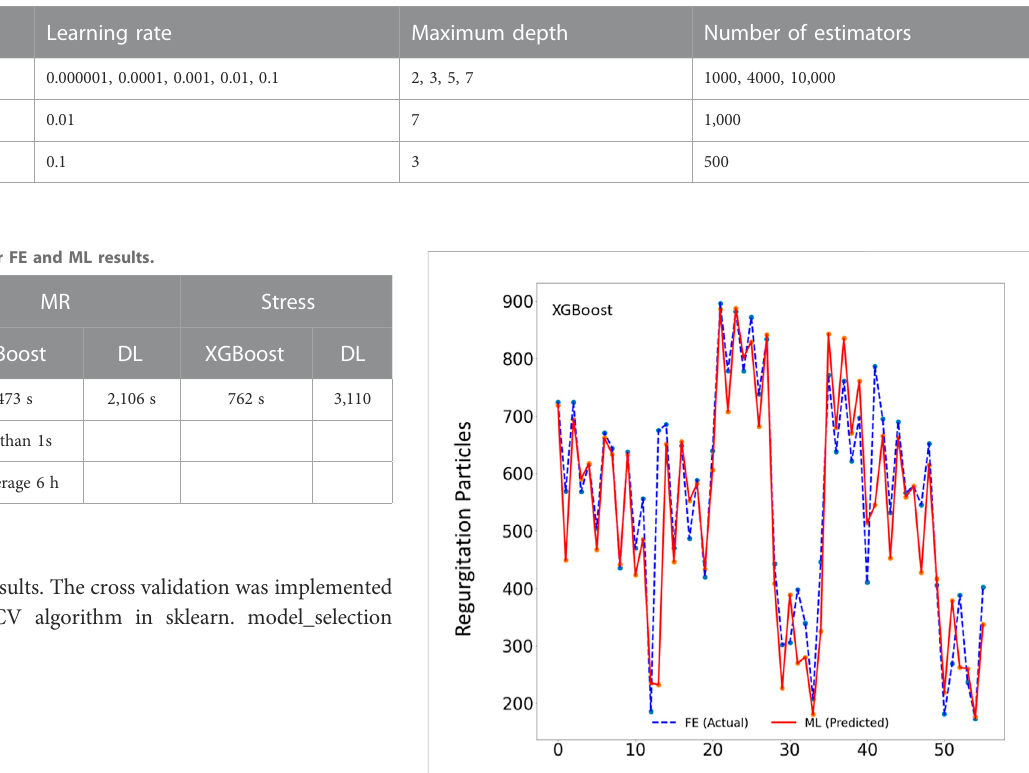
TABLE 1 Parameters used in the grid search for XGBoost algorithm.